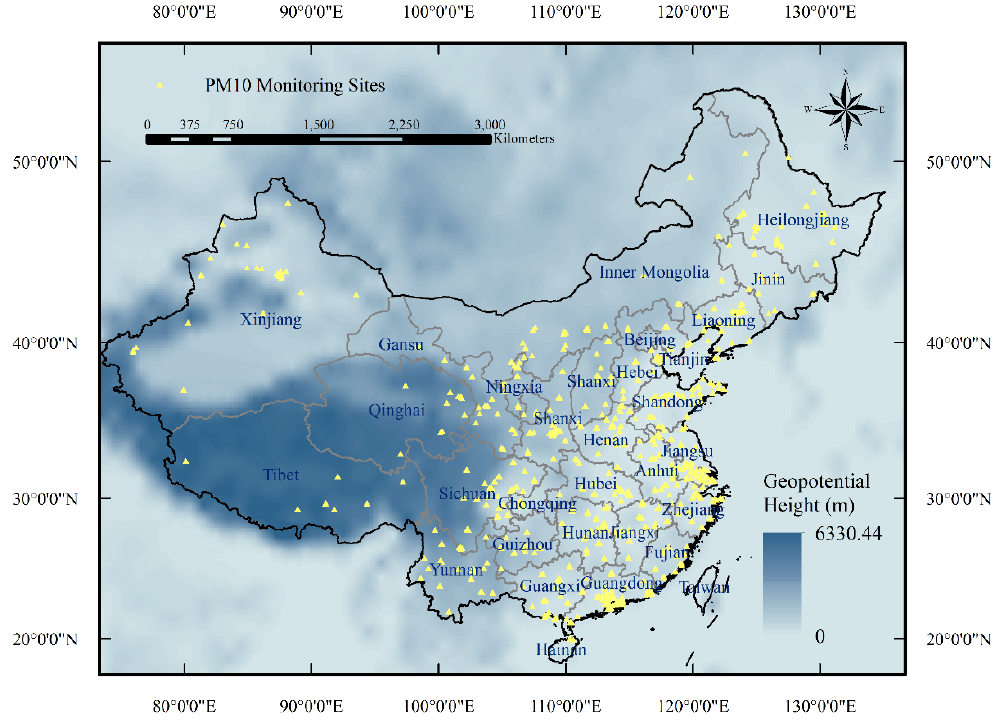
Figure 1. Spatial distribution of the 1344 PM 10 monitoring sites (solid yellow triangles) used for sample collection in this study, which displays little coverage on plateau and desert areas.